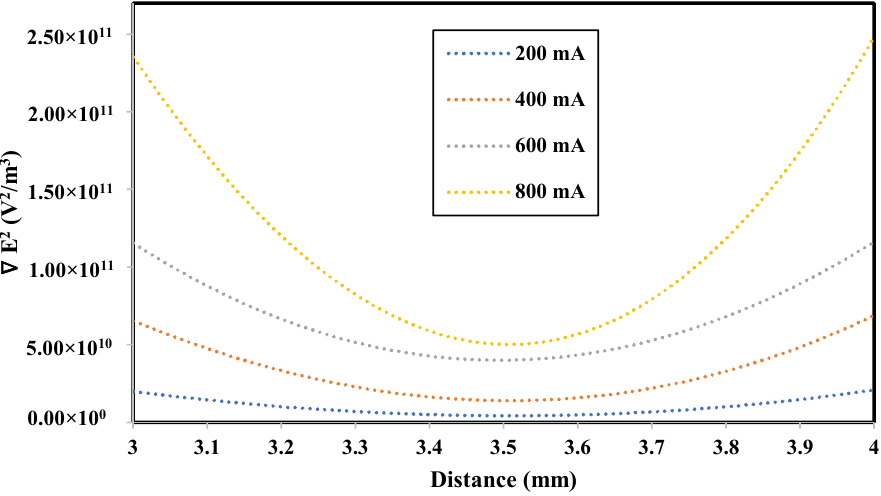
Figure 6. Electric field squared using electrode spacing of 0.5 cm and different applied currents of 200 mA, 400 mA, 600 mA and 800 mA.